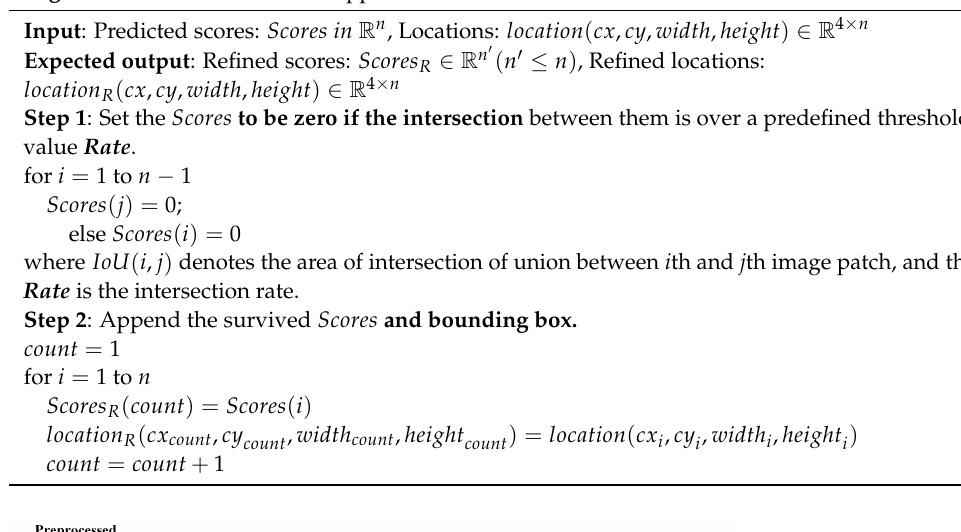
Algorithm 2 : Non-Maximum Suppression.